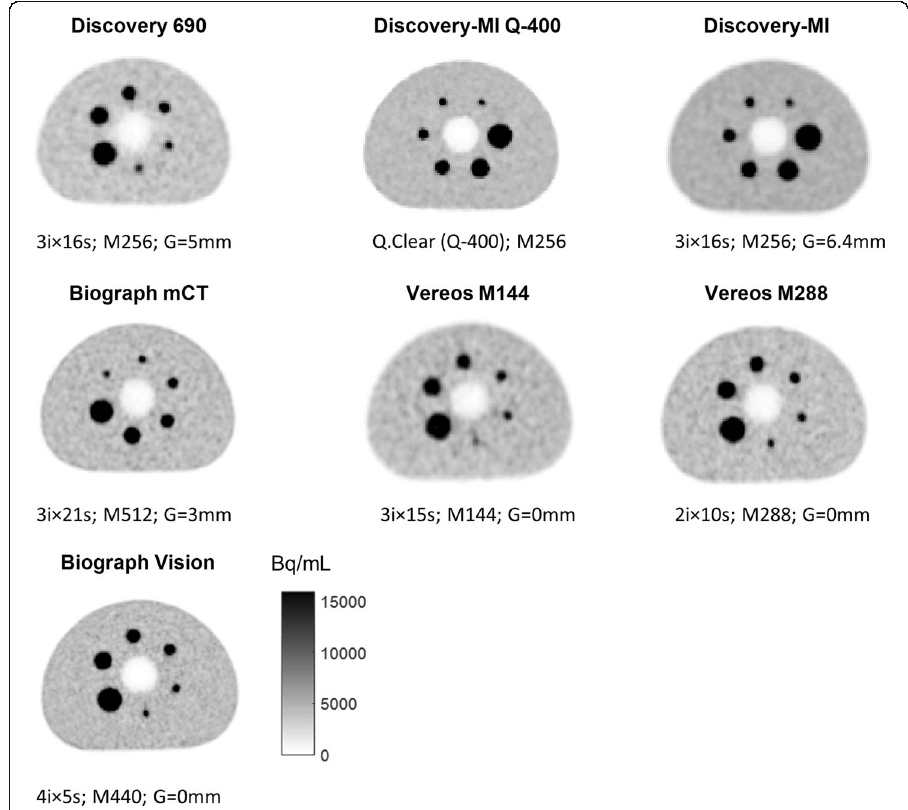
Fig. 5 Transaxial views of the image quality of phantom images obtained with clinical